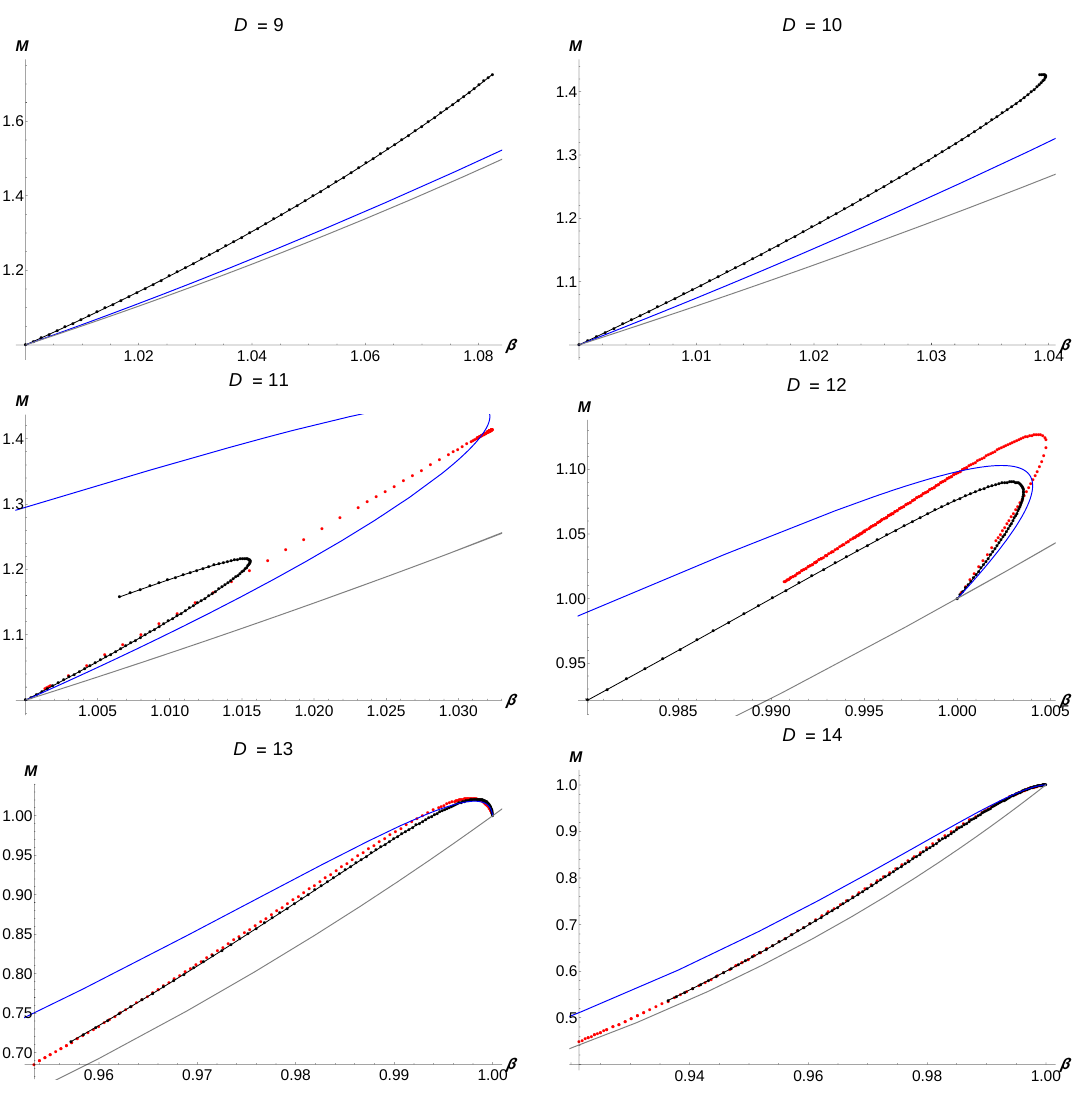
Figure 5 . Mass M vs. inverse temperature (cid:12) . Black dots: large- D numerical results for NUBS. Blue solid: large- D perturbative solution for NUBS. Red dots: (cid:12)nite- D full-numerical NUBS in [15]. Gray solid: uniform black string ( M UBS = (cid:12) n ). From the branching point at M = (cid:12) = 1, we see that (cid:12) increases when D < 12 : 5 and decreases when D > 12 : 5, while M increases when D < 13 : 6 and decreases when D > 13 :